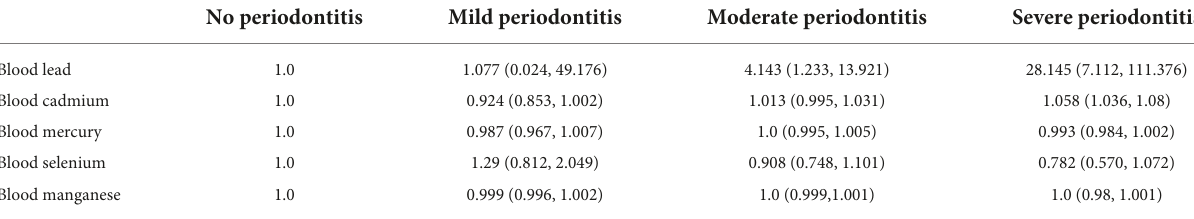
TABLE 8 Association between trace mineral concentration ( µ mol/L) and periodontal status